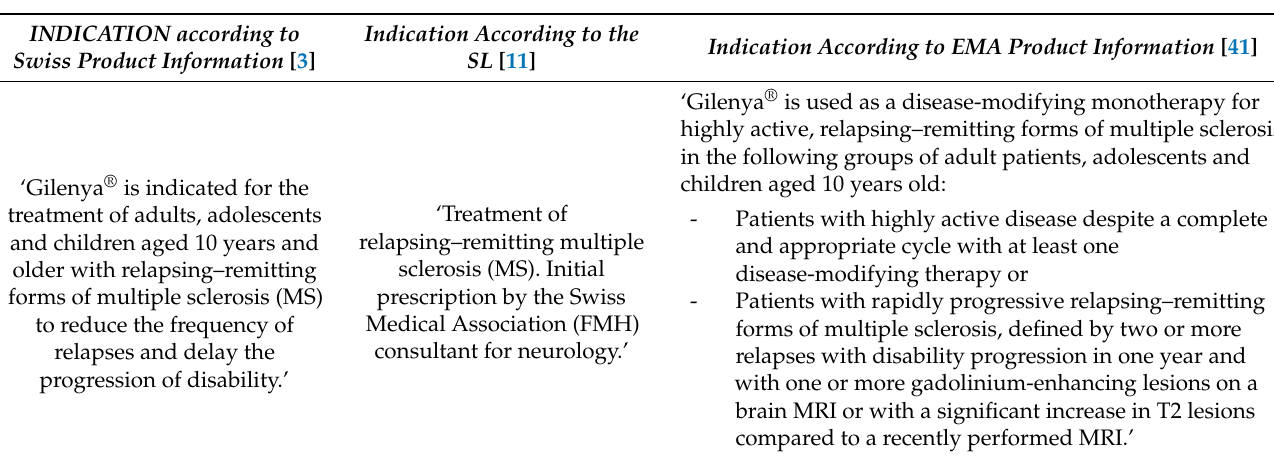
Table 11. Fingolimod (Gilenya ®